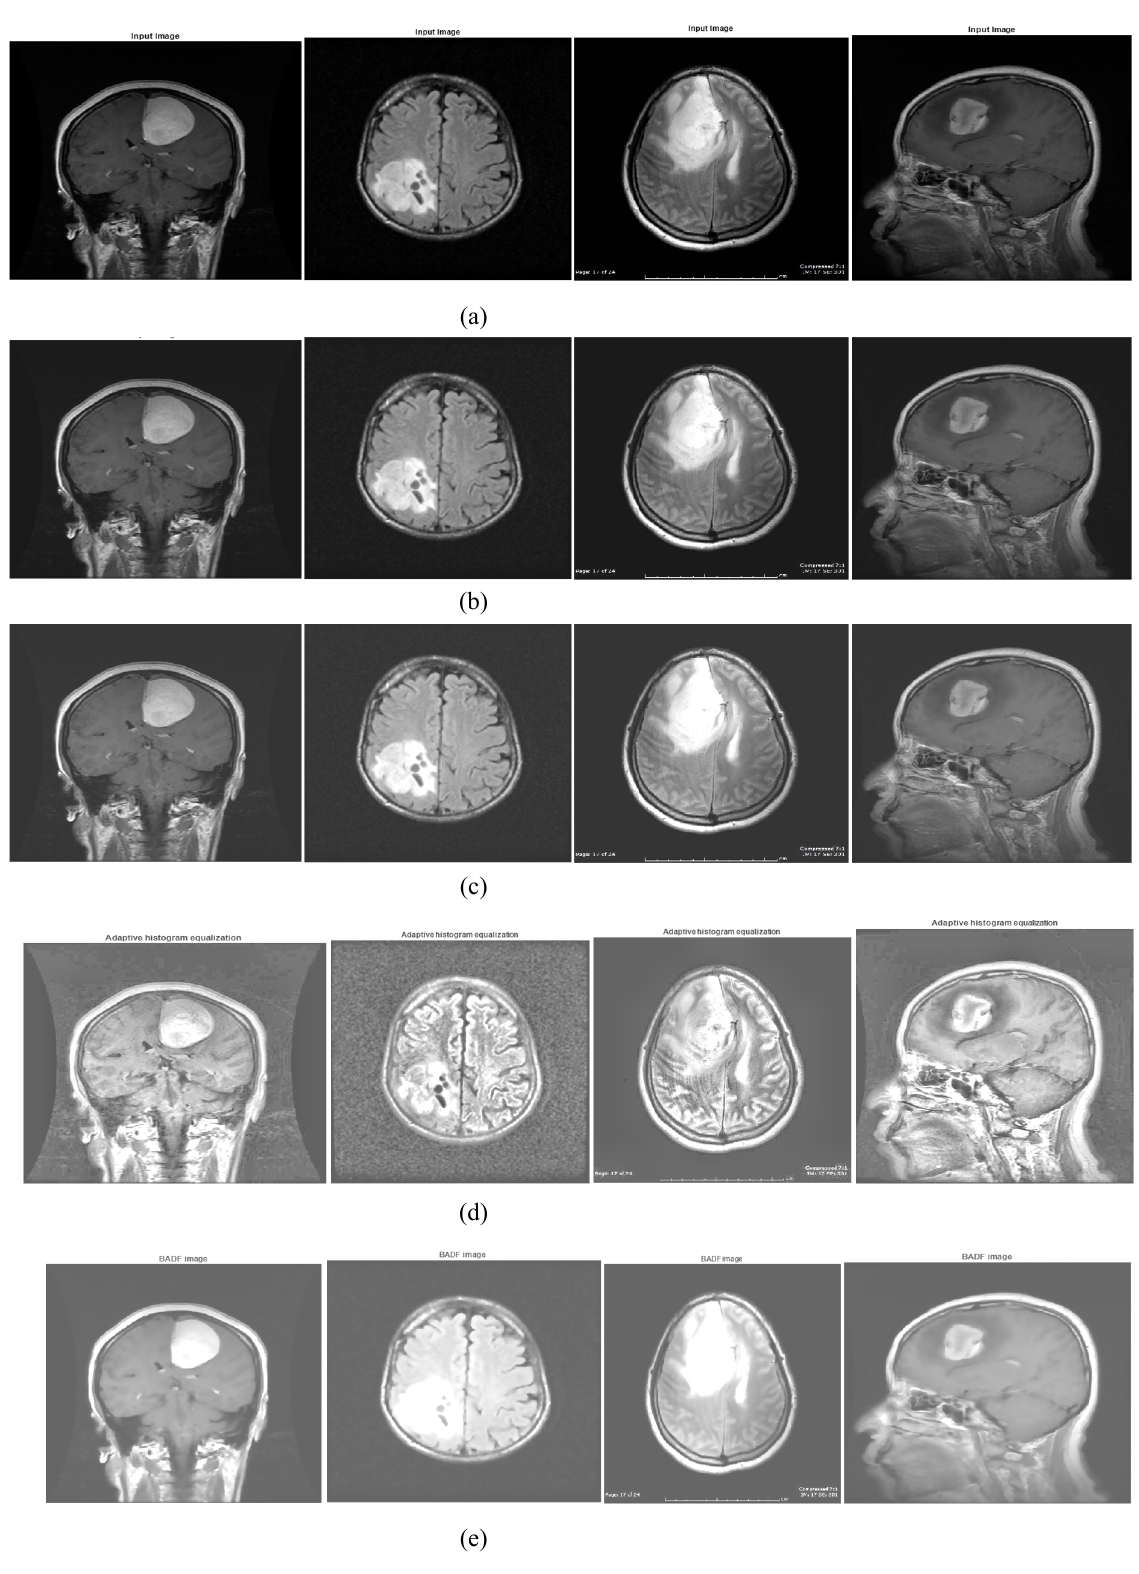
Figure 3. ( a ) Depiction of three different input image grades. ( b ) Image of bilateral filtering. The curvelet transform image is shown in ( c ). ( d ) Image with an adaptive histogram equalized histogram. ( e ) Adaptive boosted anisotropic diffusion filter.